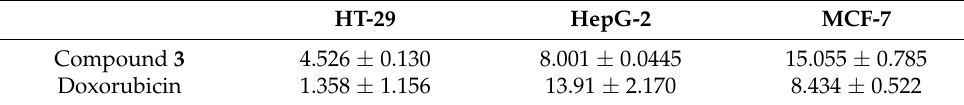
Table 2. Antiproliferative activities in different cancer cell lines (IC 50 ( µ M)).